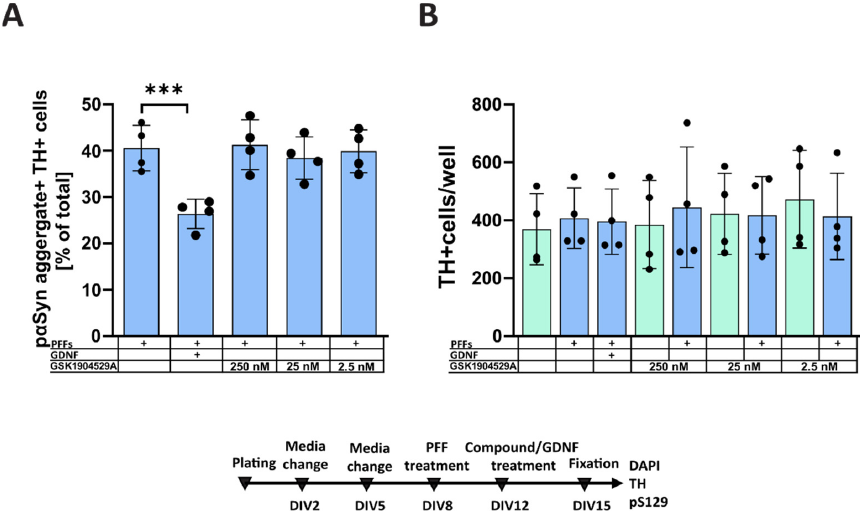
Figure 2. The effect of the selective IR and IGF-1R inhibitor GSK1904529A on α -syn aggregation in primary midbrain dopaminergic neurons, treated with PFFs. ( A ) Quantification of p α Syn-positive accumulations within TH-positive dopaminergic neurons. GDNF added to the cells on DIV12, the same day as a compound, significantly reduced the aggregations of intracellular p α Syn, while GSK1904529 showed no effect. ( B ) Quantification of TH-positive cells per well showed no significant changes, suggesting non-toxicity of the chosen concentrations of GSK1904529A to TH-positive dopaminergic cells. n = 4 independent experiments, data are mean ± SD, *** p < 0.001. To investigate whether enhancing insulin signaling through the PI3K-AKT would affect the accumulation of p α Syn in dopaminergic neurons, we selectively inhibited negative regulators of this pathway, PTEN or SHIP2, by treating primary embryonic midbrain culture with VO-OHpic (Figure 3) or AS1949490 (Figure 4), respectively. Treatment with 25 and 250 nM PTEN inhibitor VO-OHpic showed no effect, either on the accumulation of p α Syn in TH-positive neurons (Figure 3a) or on the survival of PFFs-treated dopaminergic neurons (Figure 3b).